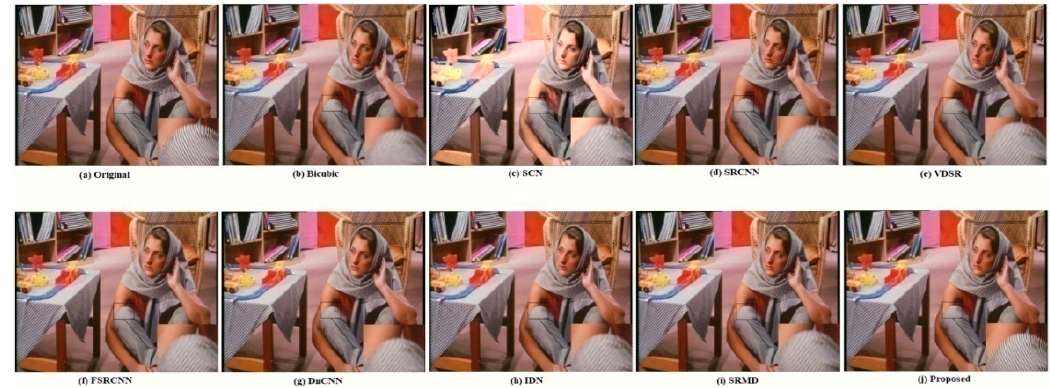
Figure 6. Visual comparison for a baboon image at the scale-up factor of 2.